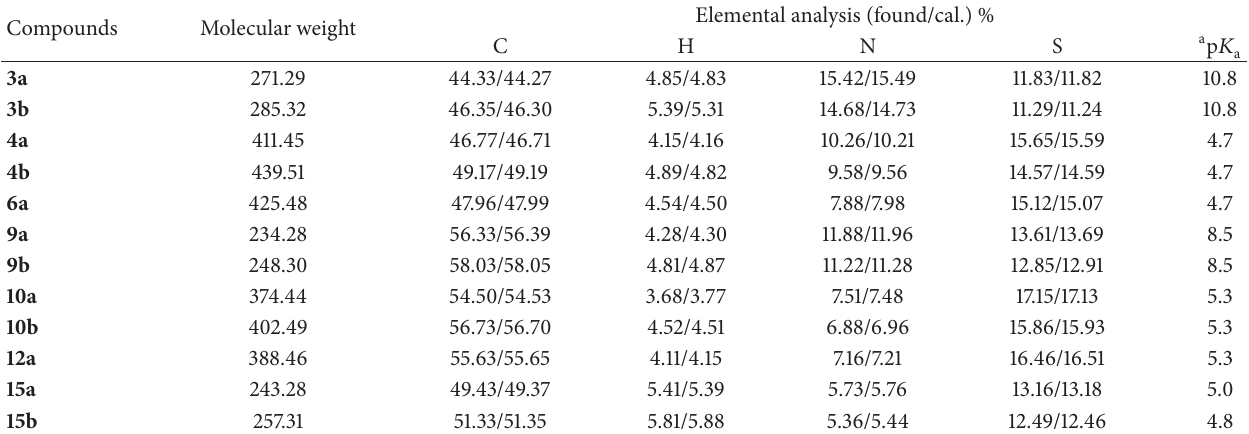
Table 1: Physiochemical and analytical data of sulfonamides.